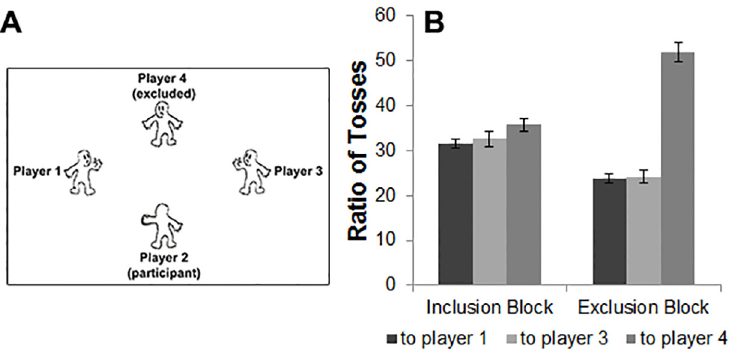
Fig 1. (A): Example of stimulus display (participant numbers are shown for illustration purposes only but were not presented to the participant), (B): Ratio of tosses from the participant to the other three players in the inclusion and exclusion